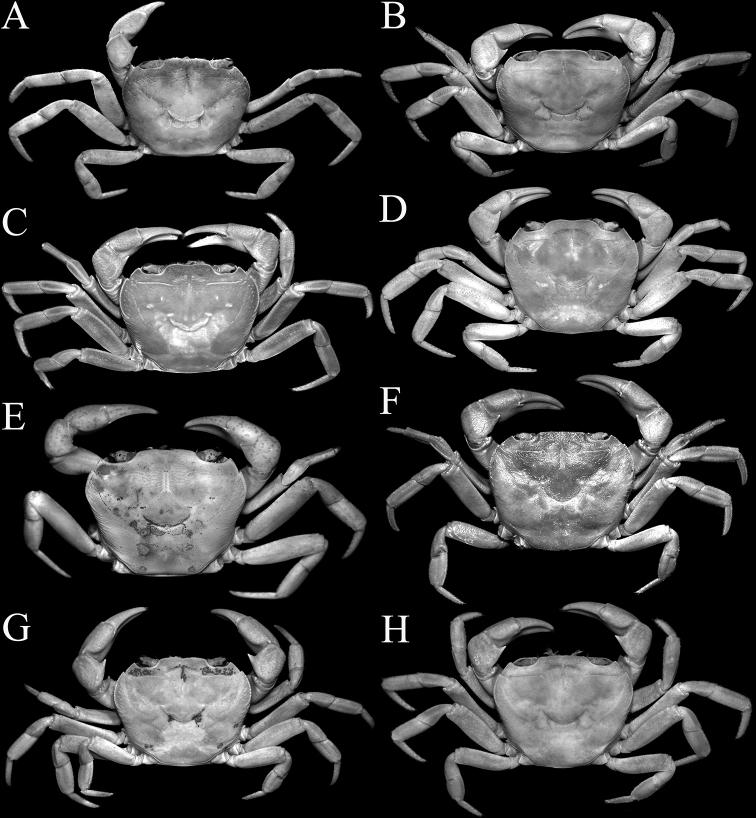
Overall dorsal view AJohora
intermedia Ng, 1986, female (17.9 × 14.7 mm) (ZRC 2001.1002), Selangor BJ.
tahanensis (Bott, 1966), female (24.4 × 21.0 mm) (ZRC 1984.6765), Pahang CJ.
thoi Ng, 1990, female (31.7 × 25.5 mm) (ZRC 2001.1167), Terengganu DJ.
hoiseni Ng & Takeda, 1992, paratype female (22.1 × 19.0 mm) (ZRC 1984.6675), Kelantan EJ.
thaiana Leelawathanagoon, Lheknim & Ng, 2005, paratype female (21.0 × 17.4 mm) (ZRC 2006.0053), Thailand FJ.
booliati sp. nov., paratype female (40.4 × 34.4 mm) (ZRC 1995.270), Pahang GJ.
erici sp. nov., paratype female (32.8 × 26.9 mm) (ZRC 1995.268), Perak HJ.
michaeli sp. nov., paratype female (29.9 × 25.0 mm) (ZRC 2010.0047), Terengganu.